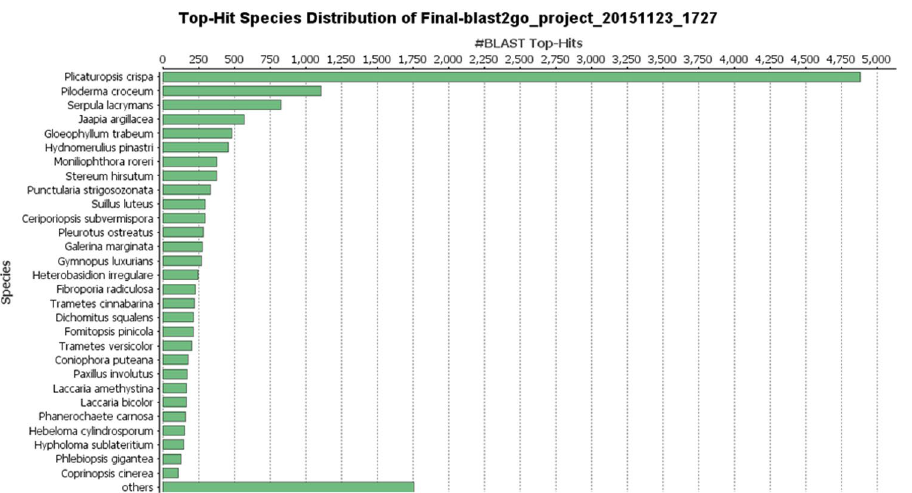
Figure 2. Distribution of blast hits among the different fungal species.